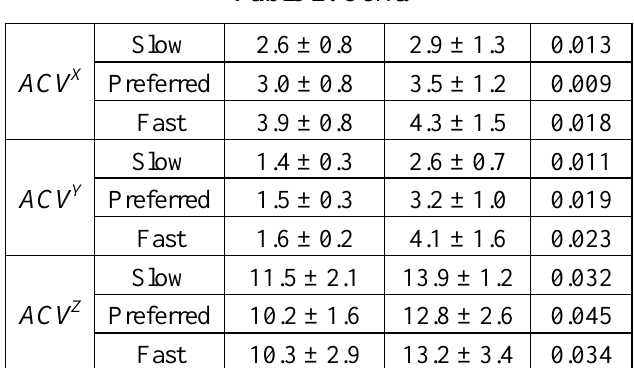
Figure 6. Statistical comparison of the evaluation parameters’ (Acop, ACV X , ACV Y and ACV Z ) mean and standard deviations (SD) for all the subjects. Light green bar: Without obstacles Dark gray bar: With obstacles